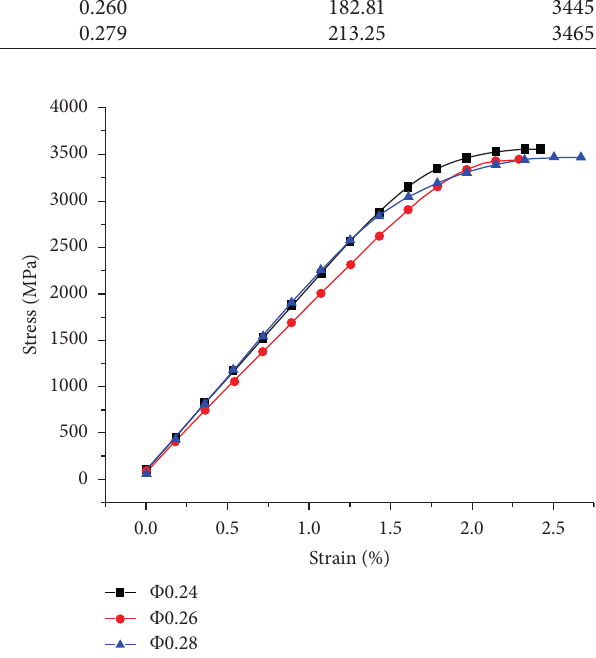
Figure 4: Steel cord single wire stress-strain curve. Table 3: Single-silk stretch performance simulation